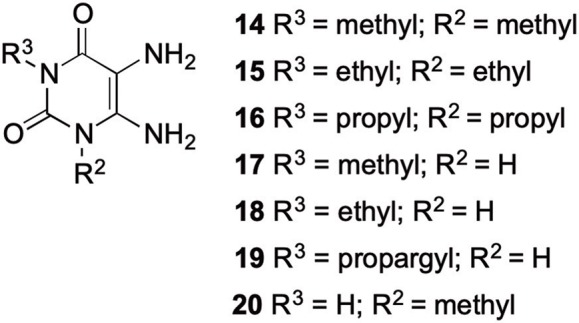
N1-Mono- and N1,N3-disubstituted 5,6-diaminouracil derivatives synthesized as starting materials for amide formation (for details see Supporting Material Data Sheet 1).